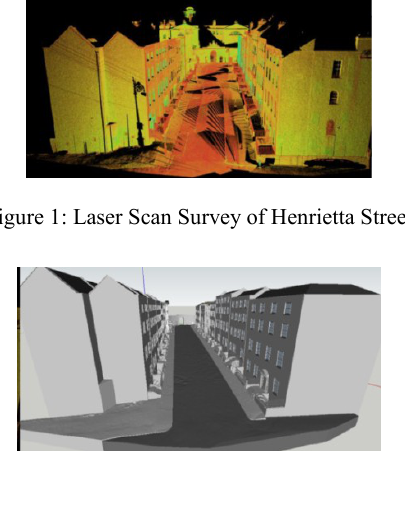
Figure 5: CityGML Objects (Dore and Murphy